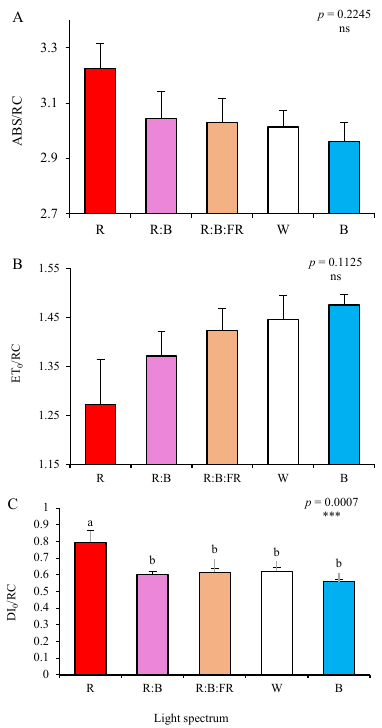
Figure 8. Specific energy fluxes per reaction center (RC) for energy absorption (ABS/RC; A ), electron transport flux (ET 0 /RC; B ), and dissipated energy flux (DI 0 /RC; C ) (equations and explanations in Table 2) of chrysanthemum cuttings exposed for 30 days to different light quality regimes (red (R), red and blue (R:B), red, blue and far-red (R:B:FR), white (W) and blue (B); see the spectrum in Figure 9). Six replicates per treatment were assessed. Columns with the same letters are not significantly different at p ≤ 0.05, according to Duncan's multiple range tests. Bars represent SEM.